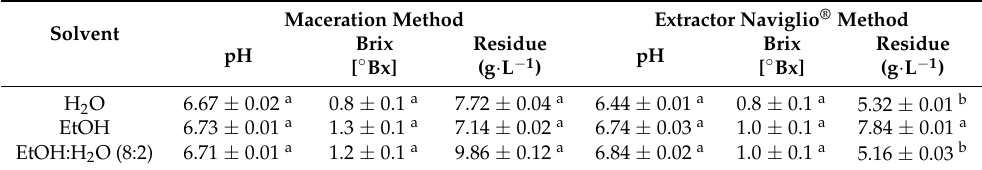
Table 1. pH, specific gravity and dry residue of the different OFP extracts at 24 h. Values are presented as mean (triplicate) ± SD. Different letters indicate significant differences between methods parameters at p <